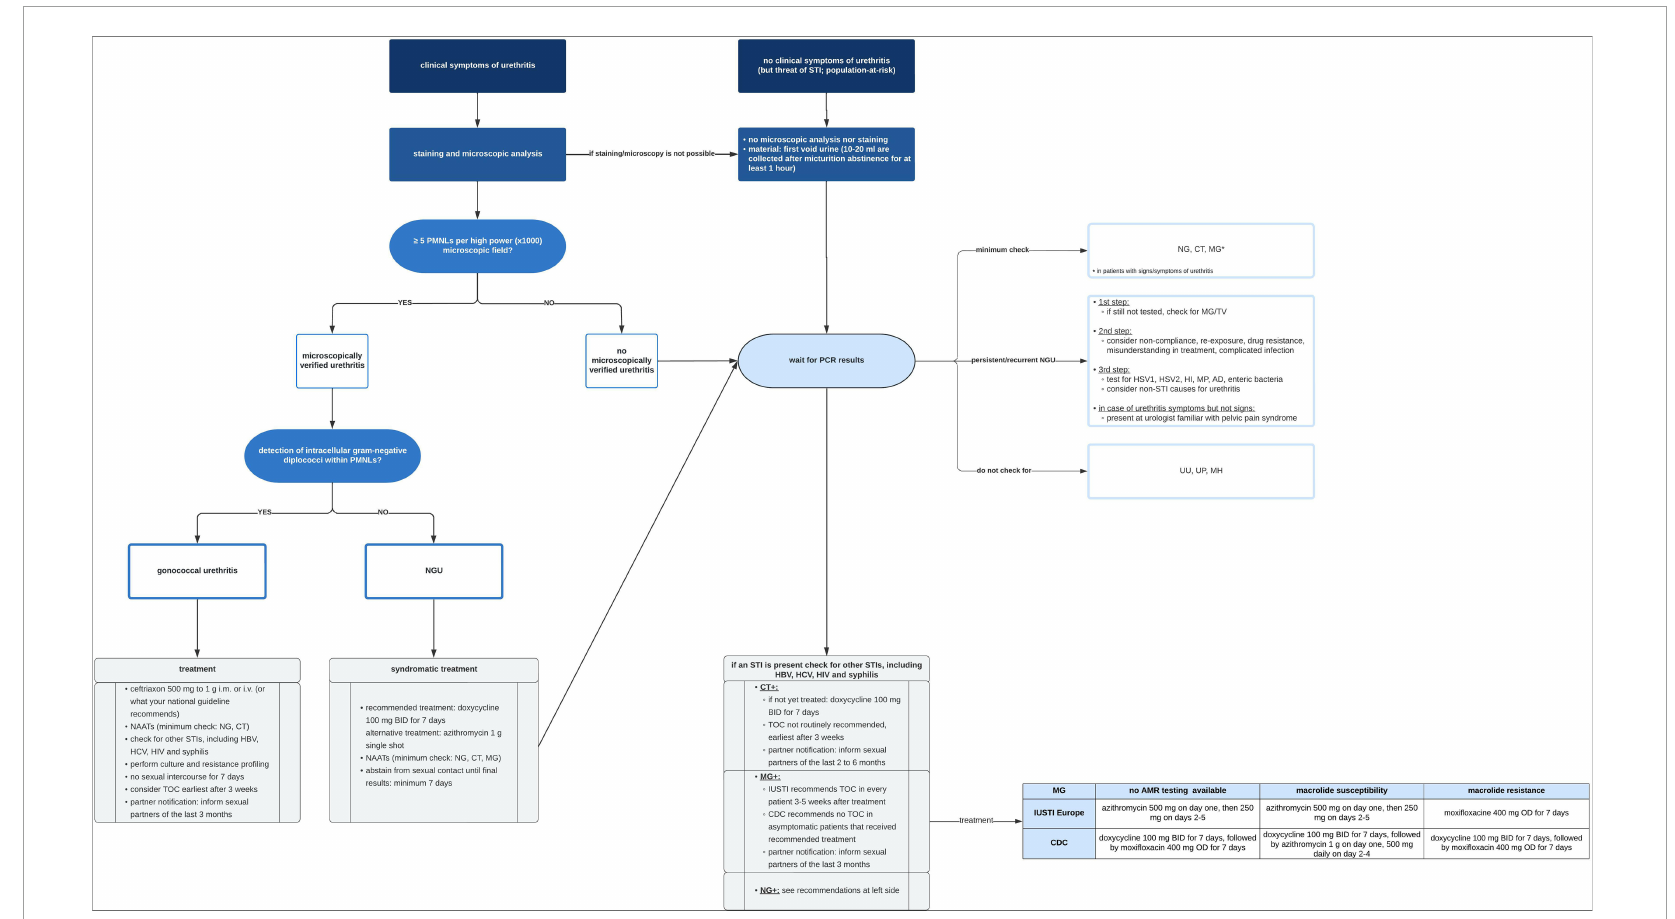
FIGURE1 Recommended diagnostic and therapeutic algorithm in case of urethritis or risk of urethral STI. AD, Adenovirus; BID, bis in die (twice a day); CDC, center of disease control and prevention; CT, Chlamydia trachomatis; HBV, hepatitis B virus; HCV, hepatitis C virus; HI, Haemophilus influenzae ; HIV, human immunodeficiency virus; HSV1, herpes simplex virus 1; HSV2, herpes simplex virus 2 ; i.m., intramuscular; IUSTI, European section of the international union against sexually transmitted infections; i.v., intravenous; MG, Mycoplasma genitalium ; MH, Mycoplasma hominis ; MP, Mycoplasma penetrans ; NAATs, nucleic acid amplification tests; NG, Neisseria gonorrhoeae ; PMNLs, polymorphonuclear leukocytes; p.o., per os ; TOC, test of cure; TV, Trichomonas vaginalis ; UP, Ureaplasma parvum; UU, Ureaplasma